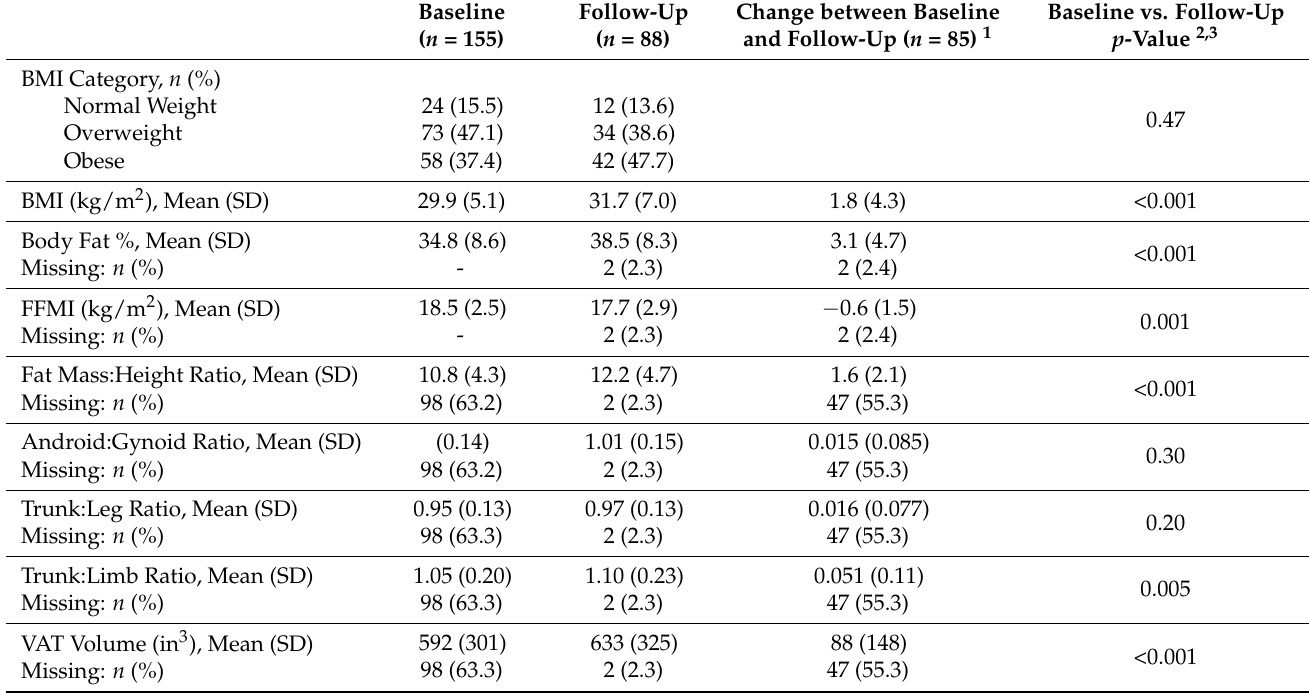
Baseline vs. Follow-Up p -Value